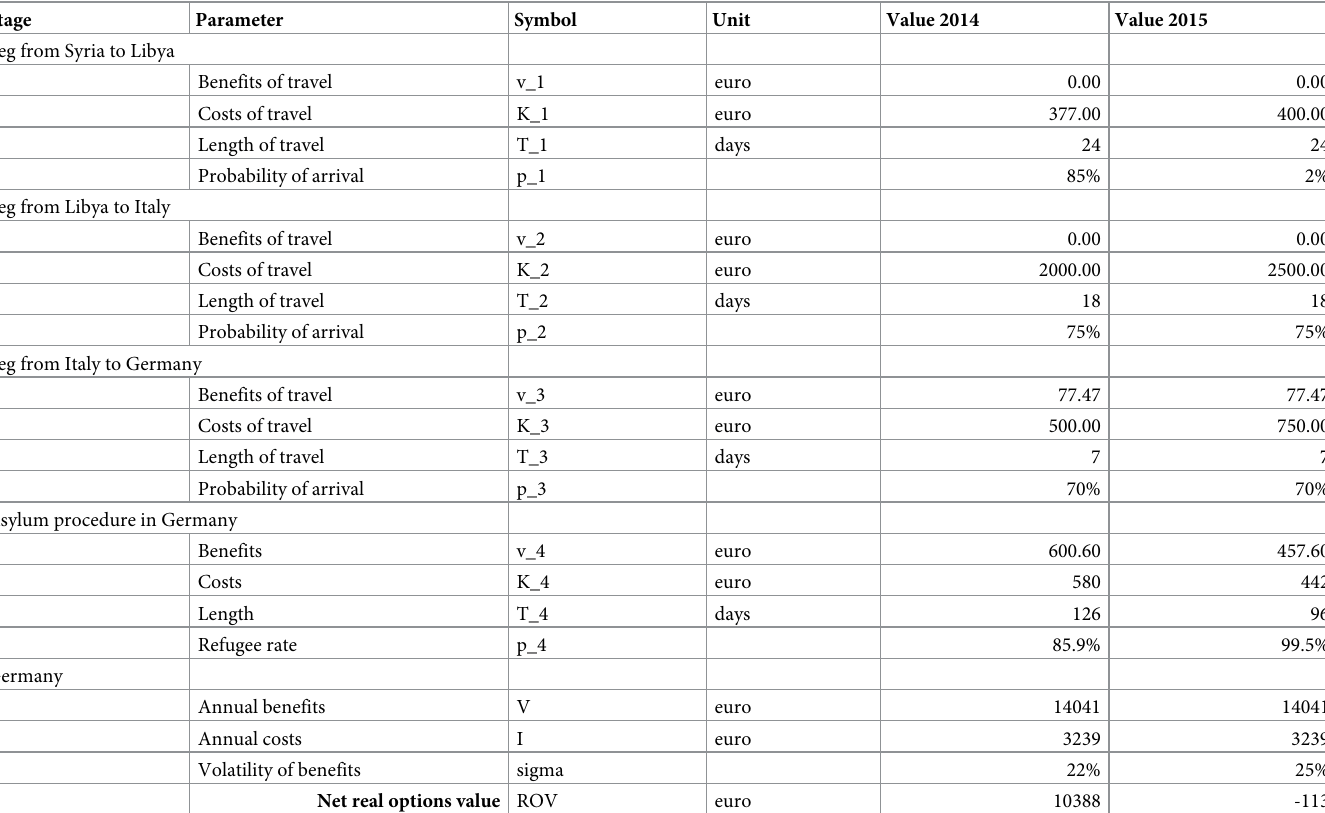
Table 1. Value drivers and real options value Central Mediterranean Route in 2014 and